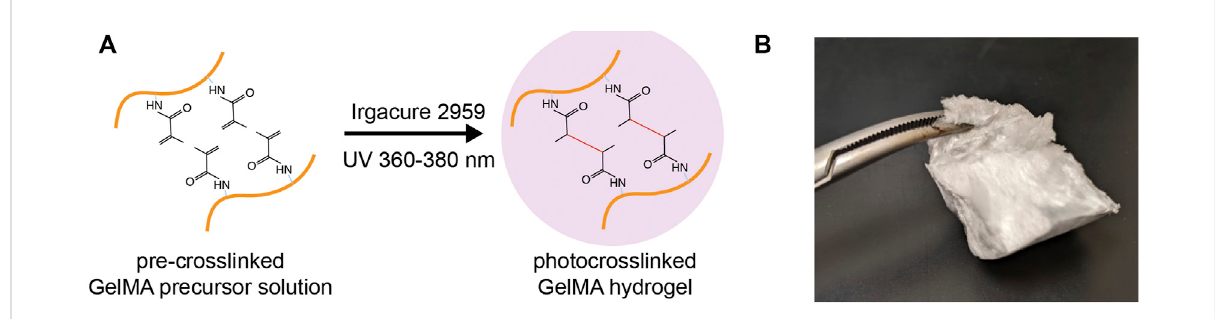
FIGURE 1 Gelatin methacrylate (GelMA). (A) Schematic depicting the photocrosslinking of GelMA from a precursor solution to a hydrogel matrix in the presence of photoinitiators and UV irradiation. (B) A piece of freeze-lyophilized GelMA